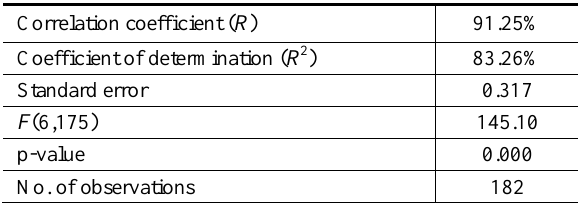
Table 1. Overall regression model statistics for